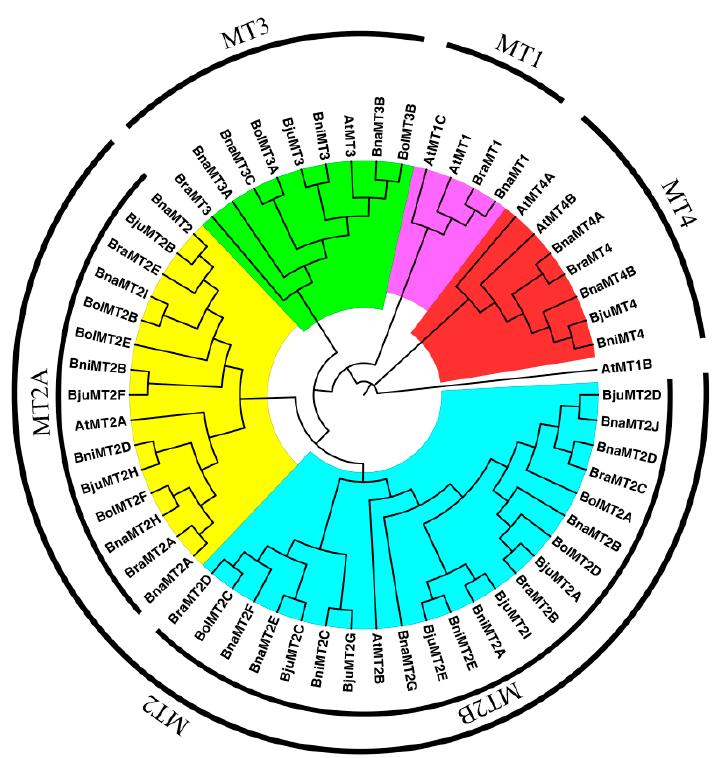
Figure 1. Neighbor-Joining (NJ) phylogenetic tree showed the relationships of Metallothionein ( MT ) family genes from A. thaliana and various Brassica species. The rooted neighbor-joining phylogenetic tree was constructed using MEGA6 and visualized using Figure Tree v1.4.2. The MTs were divided into four subfamilies (MT1-MT4), which are indicated by different colors. Organism name and gene accession numbers are shown in Table 1.